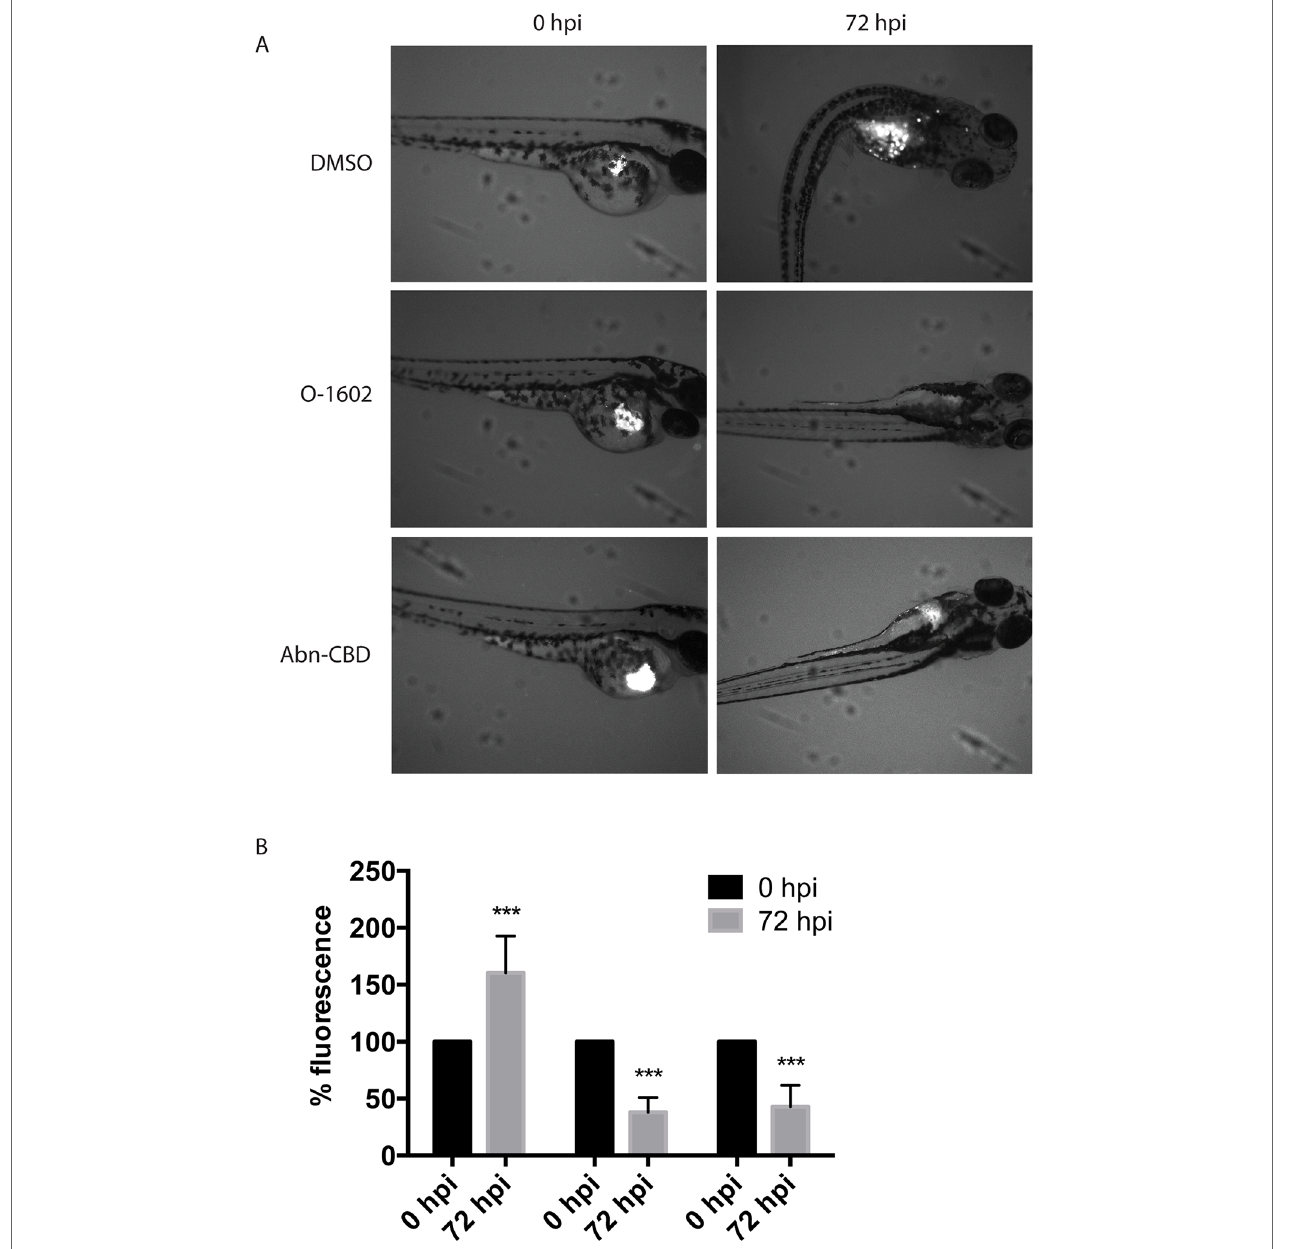
FIGURE 8 | Effect of atypical cannabinoids on the viability of Paclitaxel-resistant breast cancer cells in vivo . (A) Images of representative zebrafish injected with human MDA-MB-231 PR cells in the yolk sac (white pixels) before (0 hpf) and following 3-day treatment with the DMSO vehicle control, O-1602, or Abn-CBD (72 hpf). (B) Quantification of the analysis of more than 24 images for each condition. *** p <